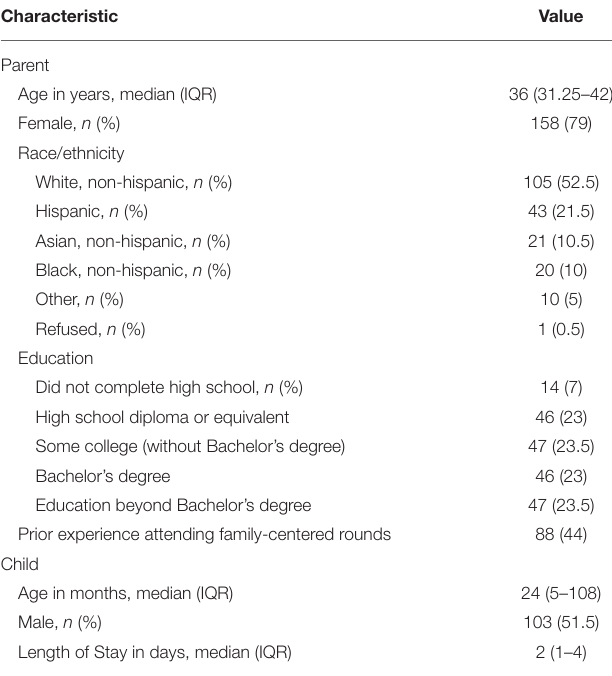
TABLE 1 | Parent and child characteristics ( n =